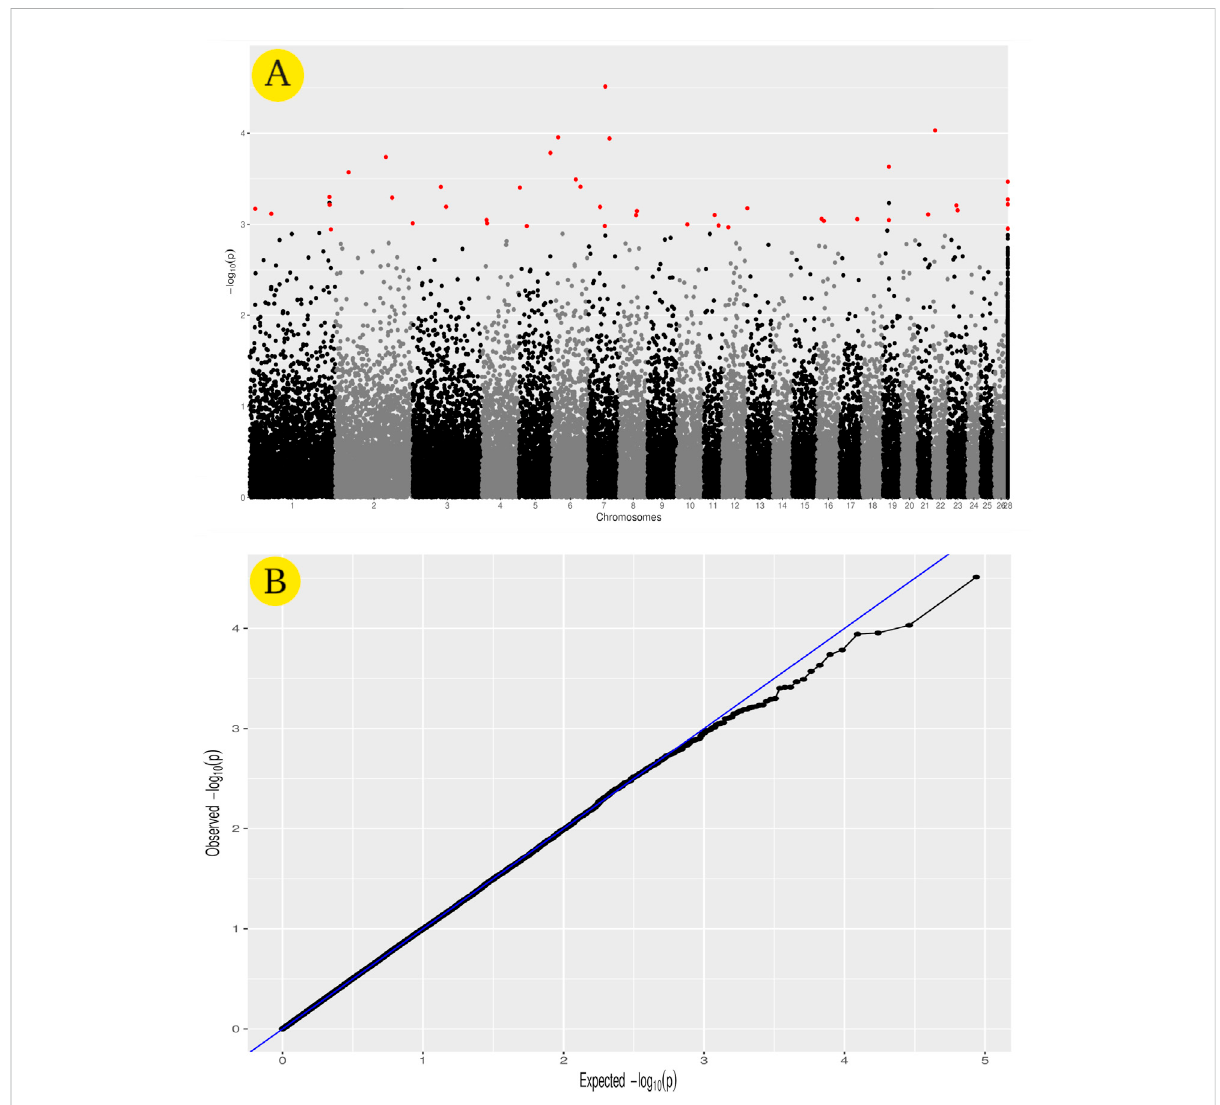
FIGURE 6 GWAS for heat tolerance in the studied Egyptian sheep breeds. The Manhattan plot of the studied genetic variation association with heat tolerance (A) , as well as the Quantile – quantile plots and Manhattan plots for the GWAS (B)